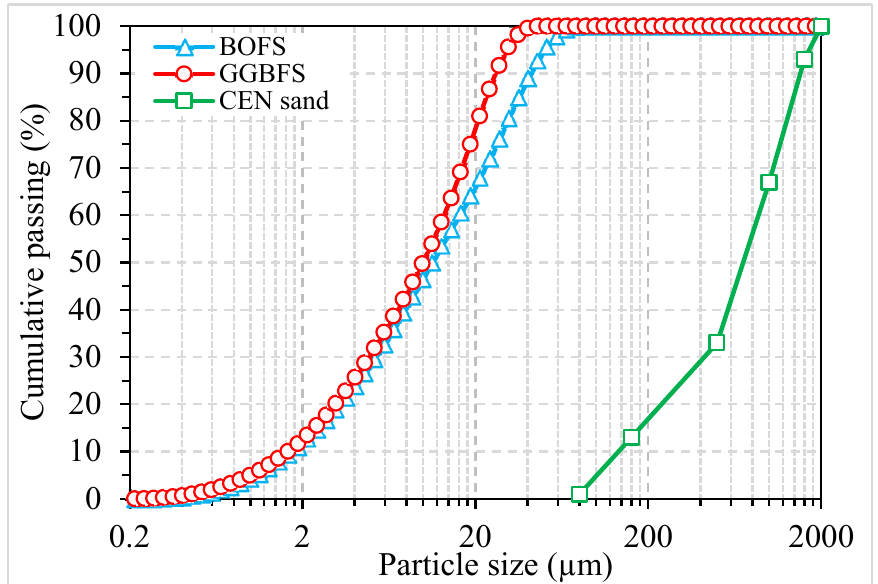
Figure 1. Particle size distribution of binders and sand.